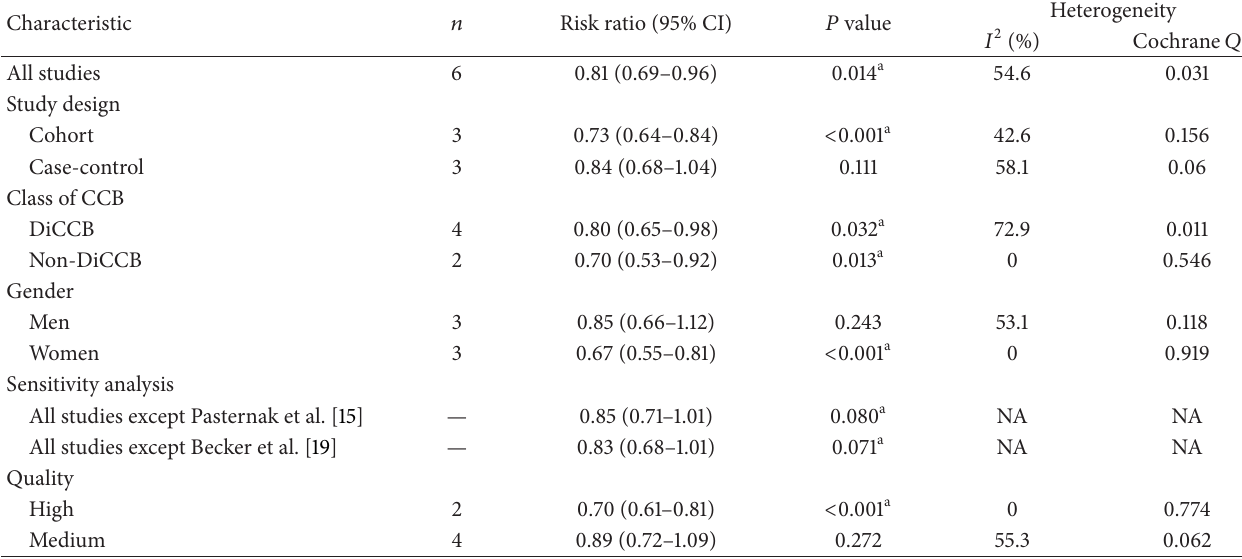
Table 3: Overall effect estimates for Parkinson’s disease and calcium channel blockers use according to study characteristics.